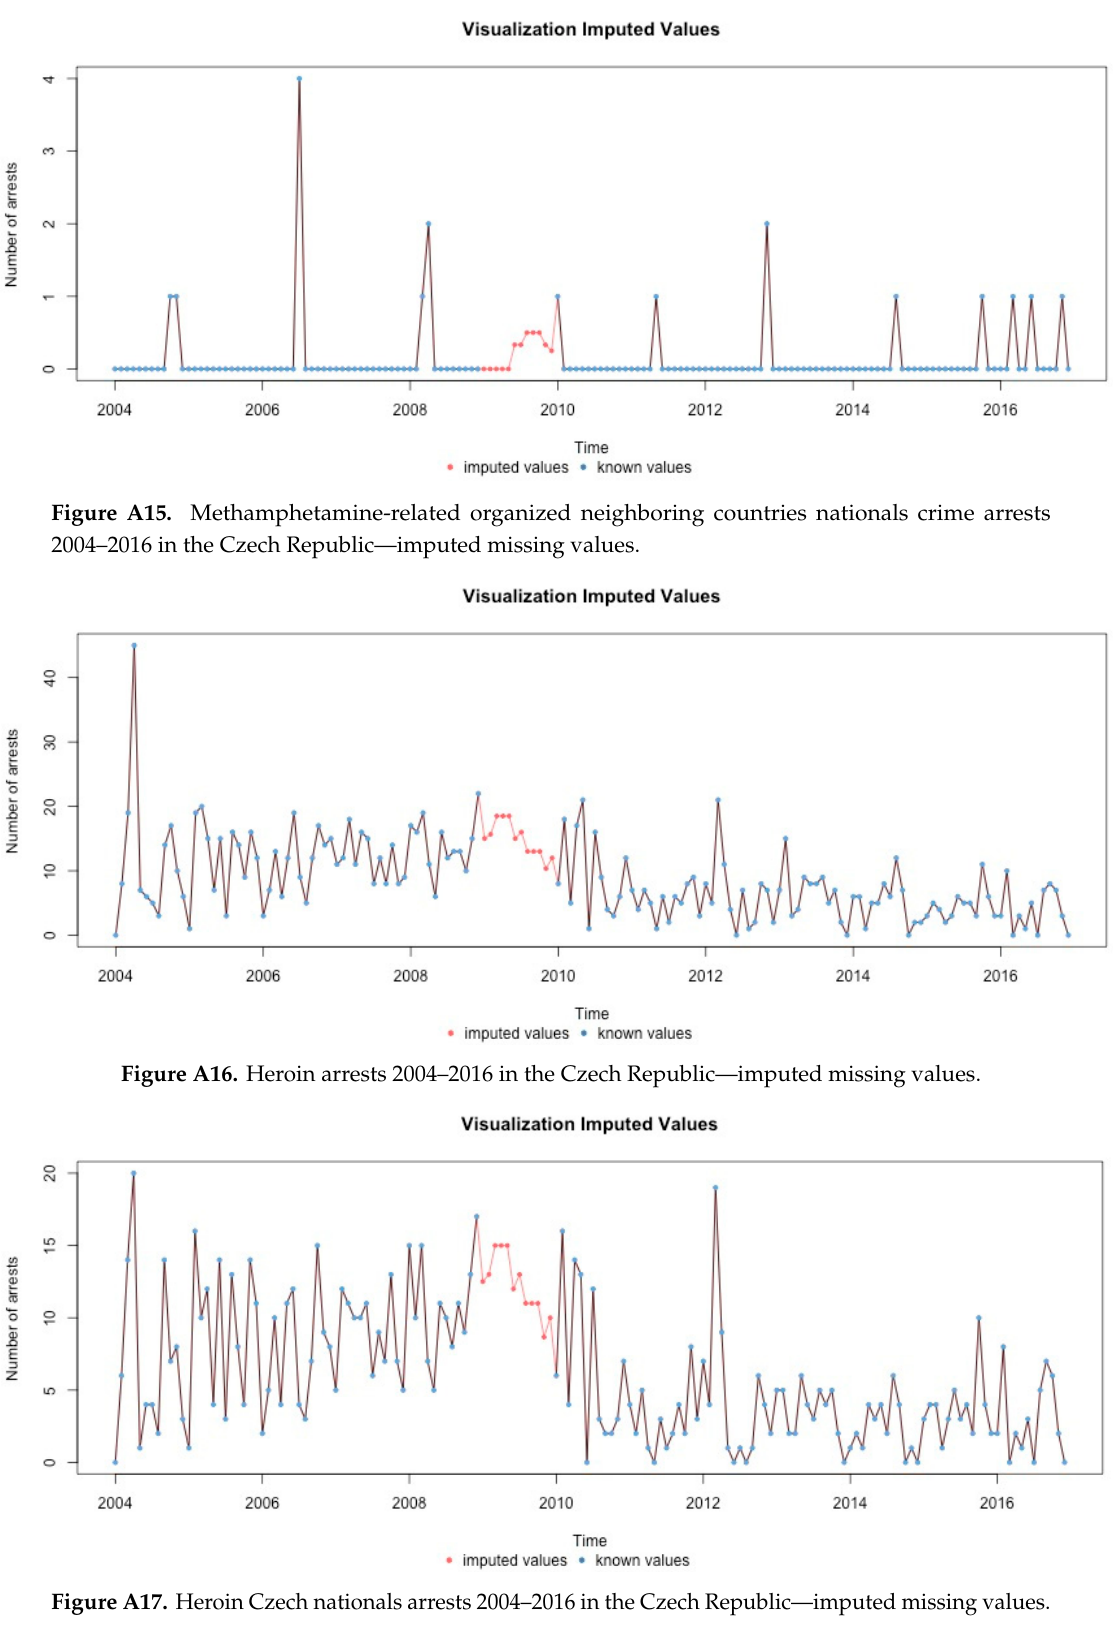
Figure A18. Heroin foreign nationals arrests 2004–2016 in the Czech Republic – imputed missing values.